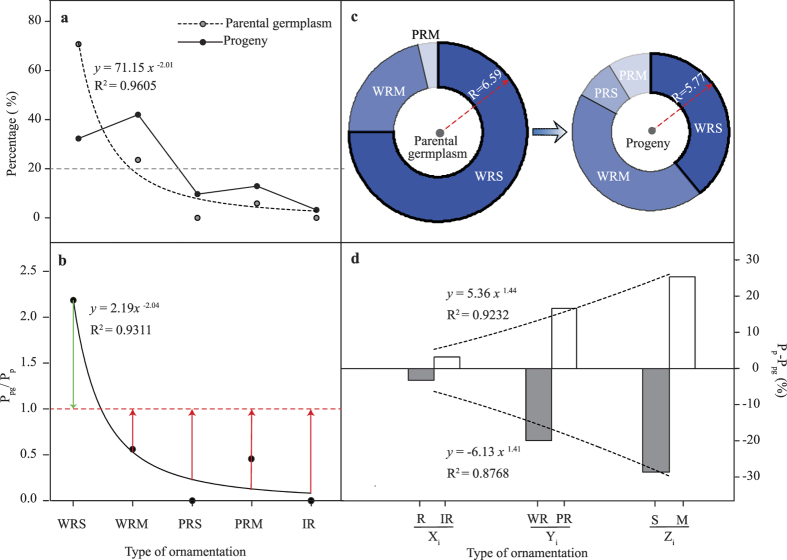
Comparison of pollen ornamentation regularities between parental population and progeny population.(a) The pollen ornamentation types’ constitution and weight distribution of parental population and progeny population of flowering crabapple. (b) The weighting ratio (PPg/PP) distribution of ornamentation types in the two populations. Green column length (PPg/PP − 1) stands for the relative weight (the weight of WRS type in parental population exceeds that in progeny population); red column length (1 − PPg/PP) stands for relative weight (the weight of pollen types in progeny population exceeds that in parental population). (c) The average score of pollen ornamentation degree of regularity of two populations and the weight of score of each type. The radius of circle presents the average score value; the pie chart presents the weight constitution of the ornamentation types scores of pollen germplasms. (d) Weight differential of pollen ornamentations of the two populations in three dimensional directions (Xi Yi Zi). PPg, percentage of parental germplasms quantity of each ornamentation type; PP, percentage of progeny quantity of each ornamentation type.